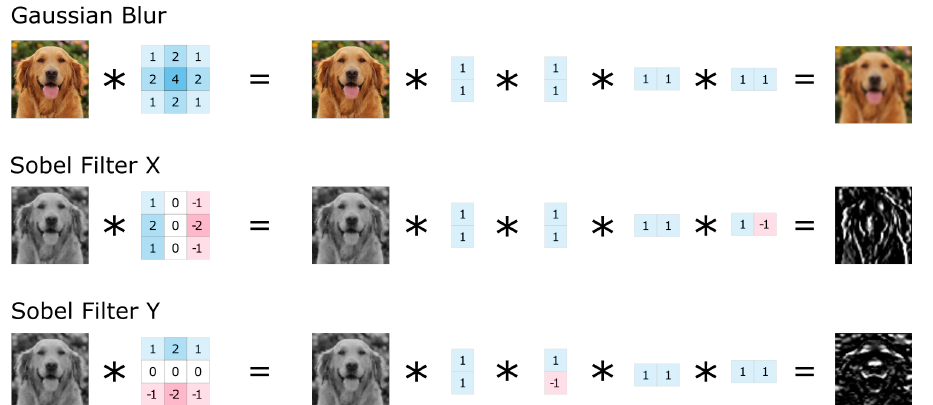
Figure 4. Examples of how jet feature building blocks can be applied through successive convolutions to implement classic computer vision kernels.